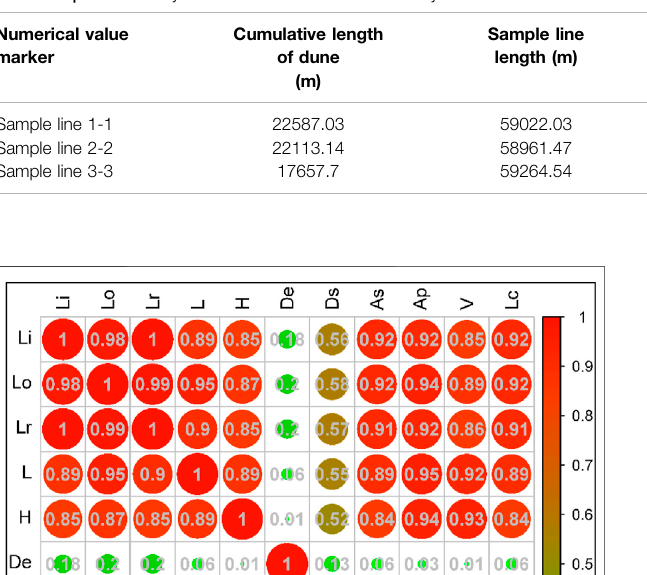
TABLE 2 | Dune density and interdune bottomland density.